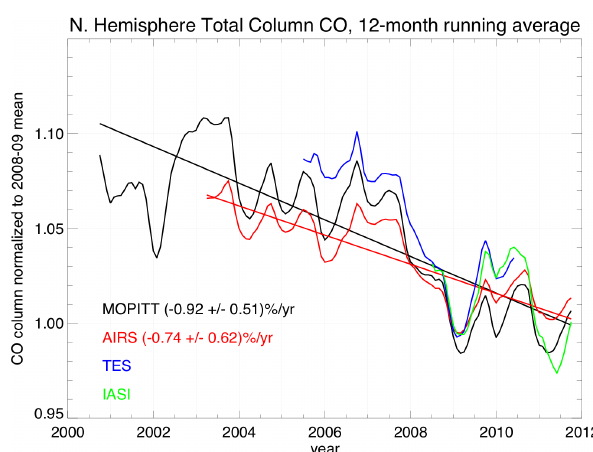
Figure 6. 12-­‐month running averages for N. hemisphere total column CO measurements normalized by the 8/2008 -­‐7/2009 average CO column for each instrument. Fig. 6. 12-month running averages for N. Hemisphere total column CO measurements normalized by the 08/2008–07/2009 average CO column for each